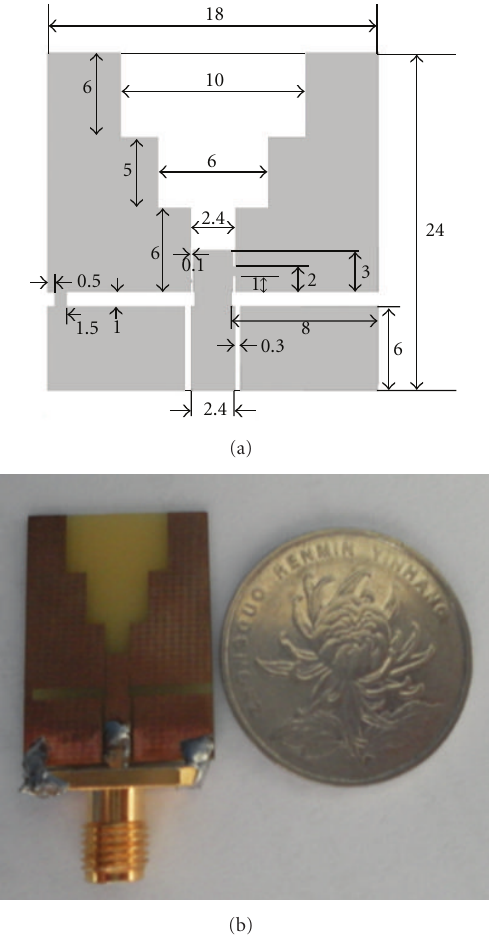
Figure 1: The configuration of the proposed antenna and photo- graph of prototype. (a) Configuration of the proposed antenna, (b) photograph of prototype.